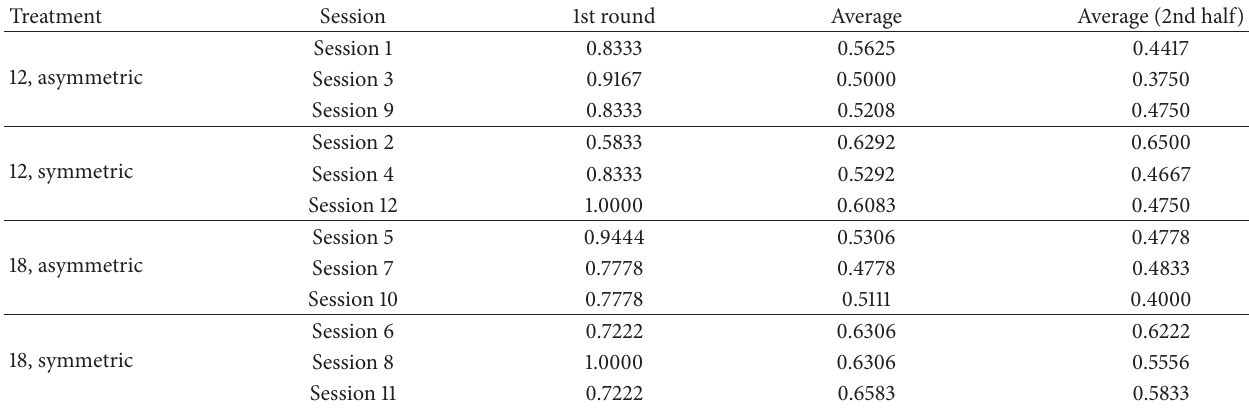
Table 10: Voting turnout rates by session.